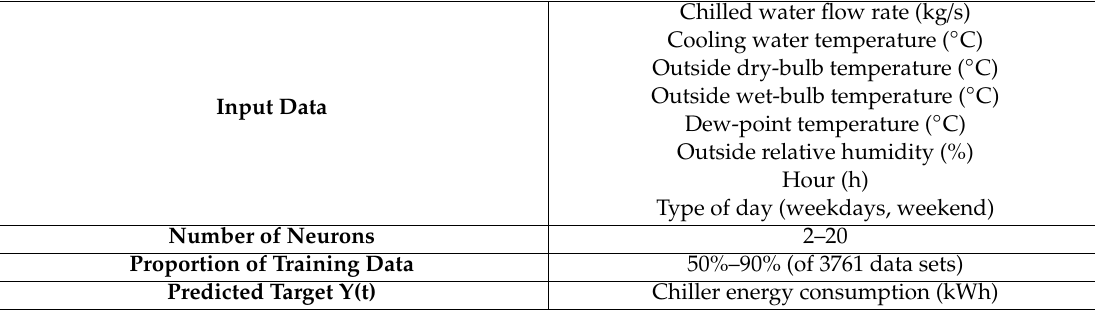
Table 4. Input / output conditions for chiller energy prediction